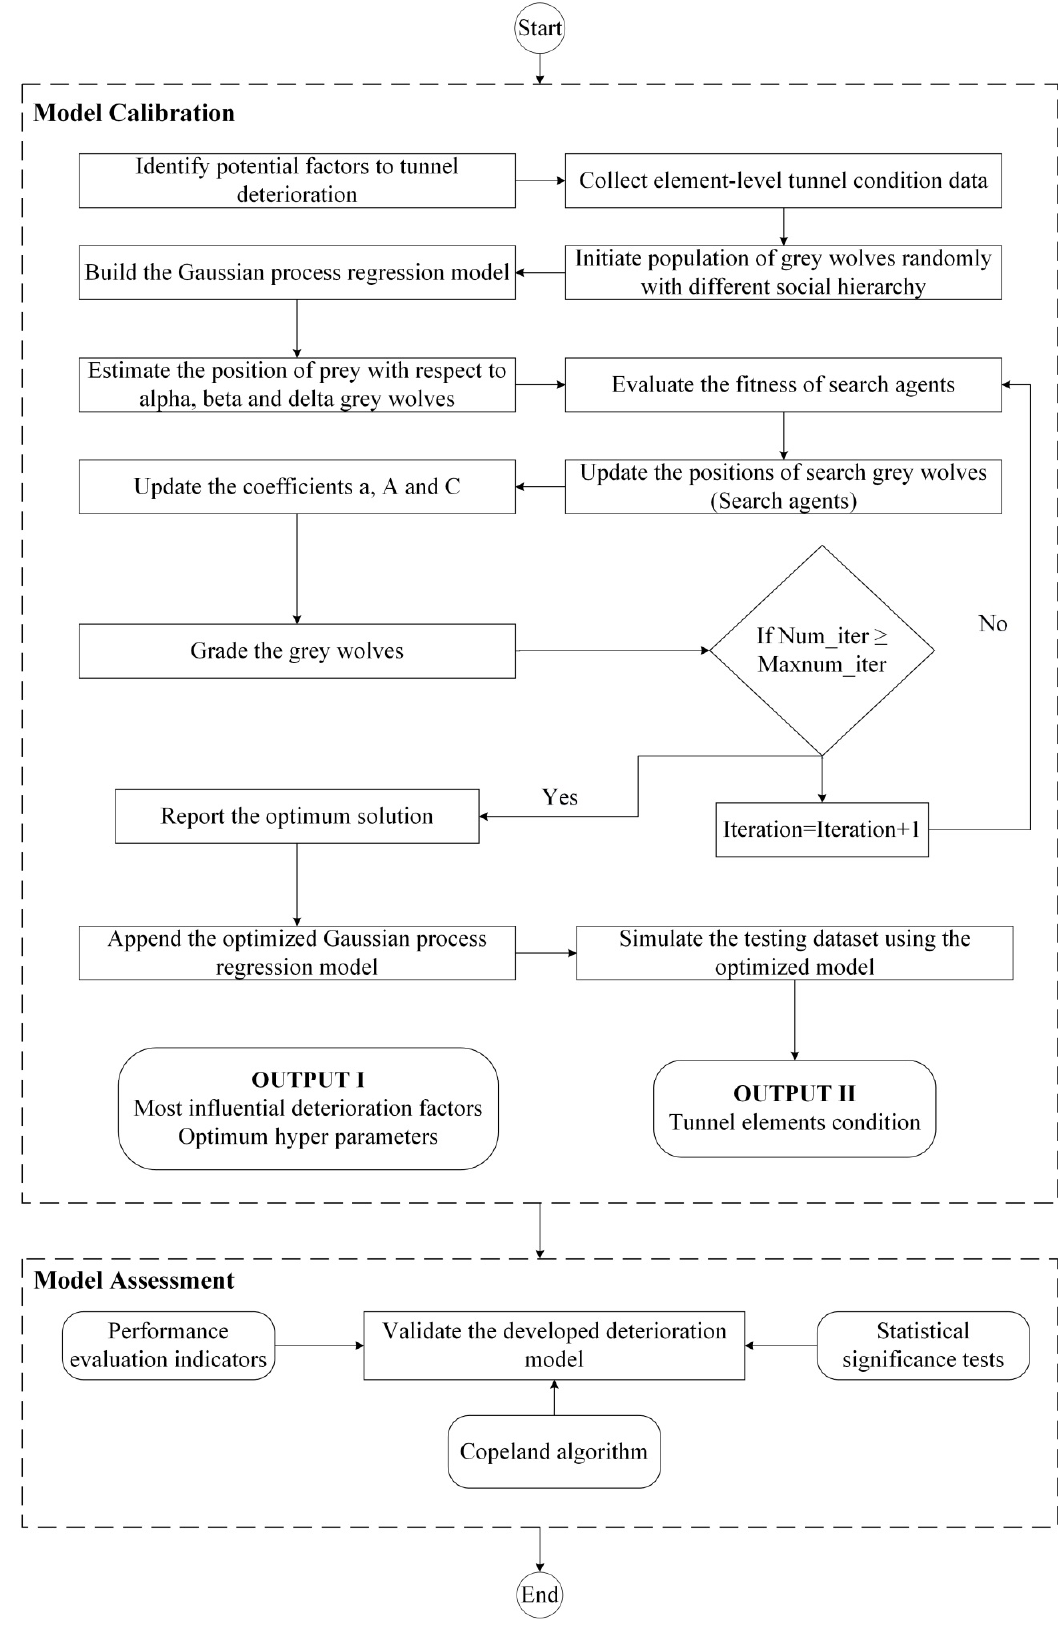
Figure 1. Framework of the developed tunnel deterioration prediction model.